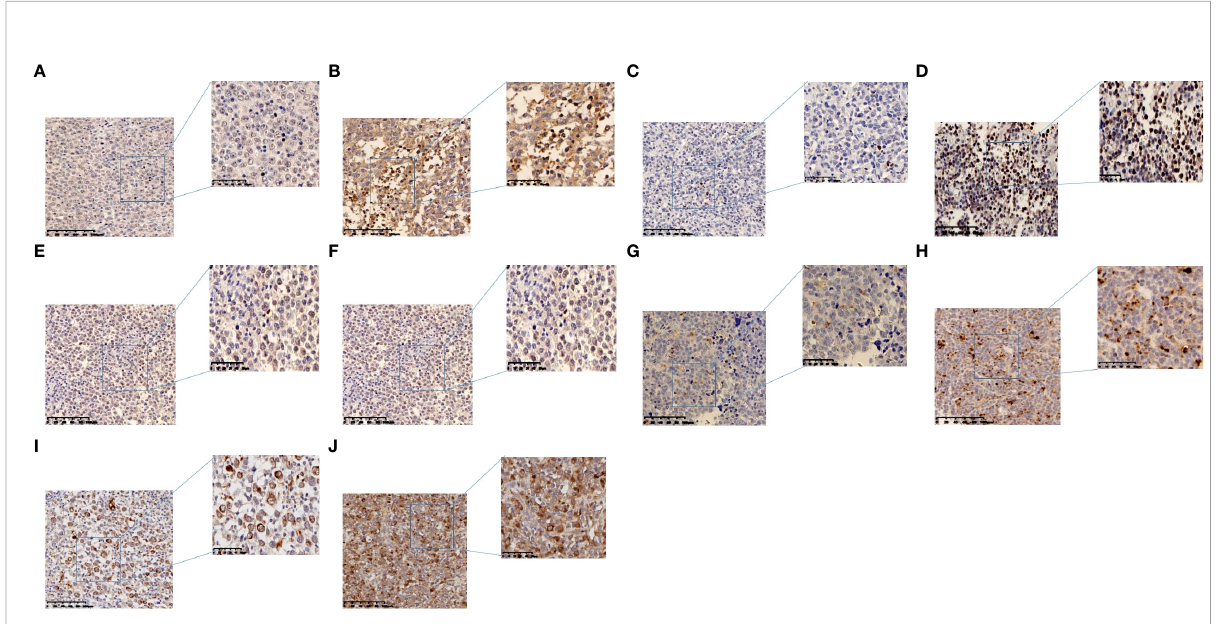
FIGURE 1 Representative images of immunohistochemistry in DLBCL. (A) Low PD-1 expression in TILs. (B) High PD-1 expression in TILs. (C) Low LAG-3 expression in TILs. (D) High LAG-3 expression in TILs. (E) Low TIM-3 expression in TILs. (F) High TIM-3 expression in TILs. (G) Low TIGIT expression in TILs. (H) High TIGIT expression in TILs. (I) TIM-3 expression in tumor cells. (J) TIGIT expression in tumor